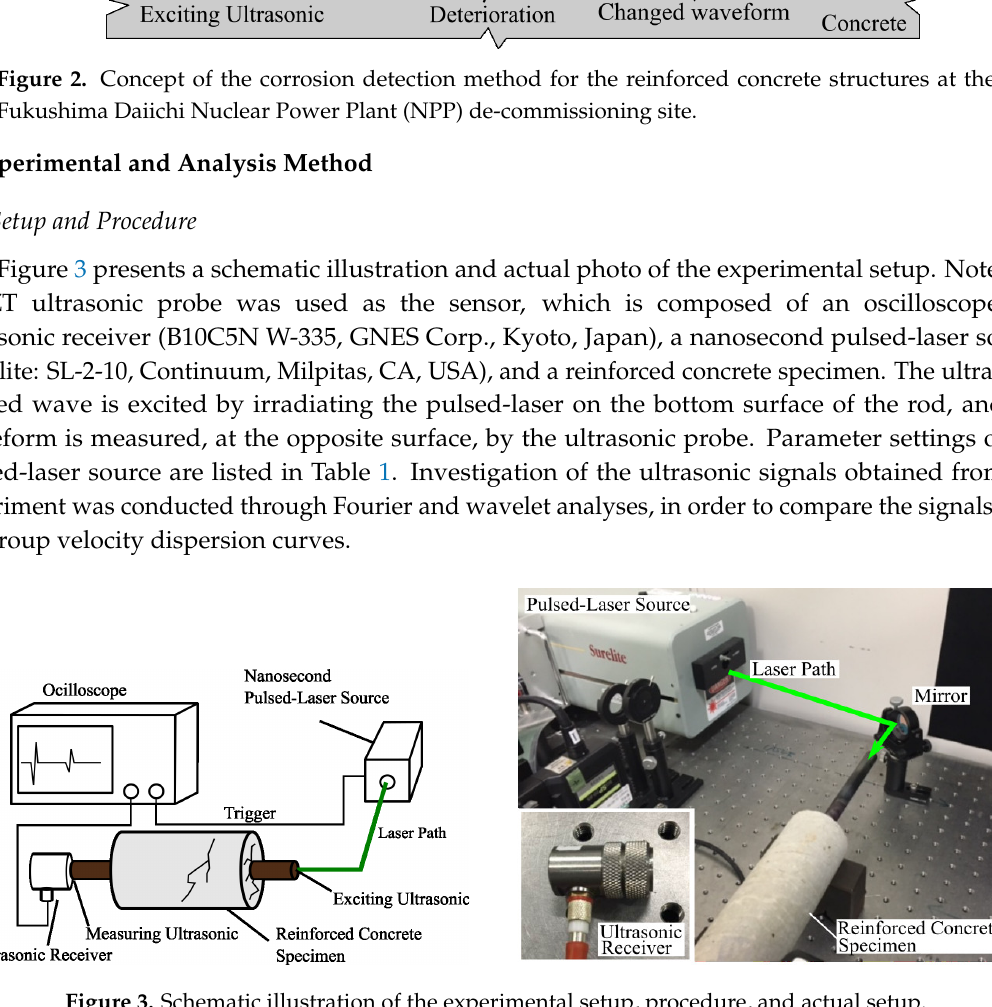
Figure 3. Schematic illustration of the experimental setup, procedure, and actual